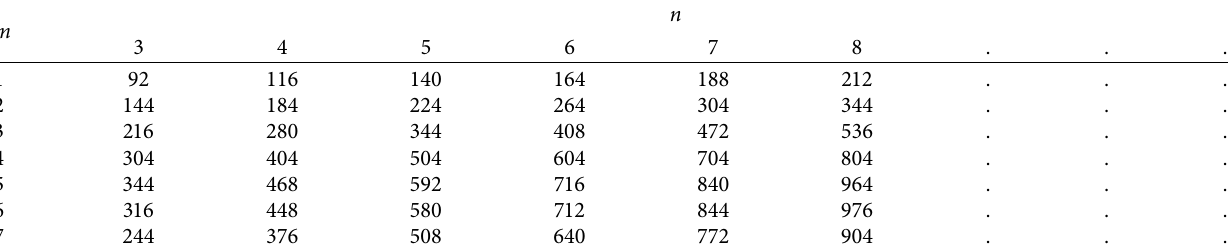
Table 1: Pair of vertices in HHC-1 at different distances.